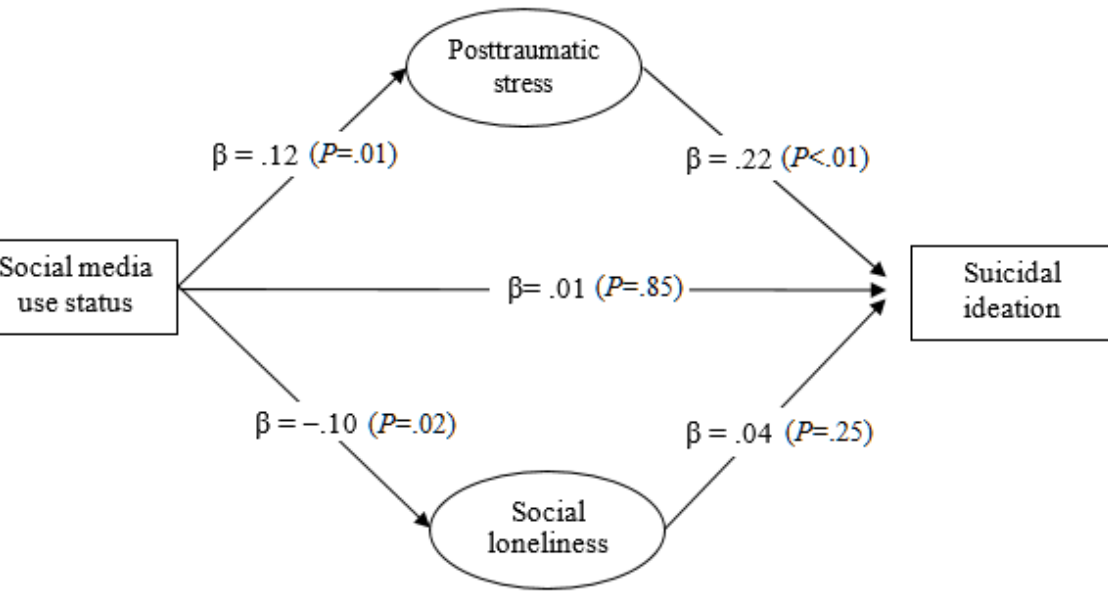
Figure 4. The proposed mediation model of suicidal ideation with standardized regression coefficients ( β ) among older adults in Hong Kong during the COVID-19 pandemic